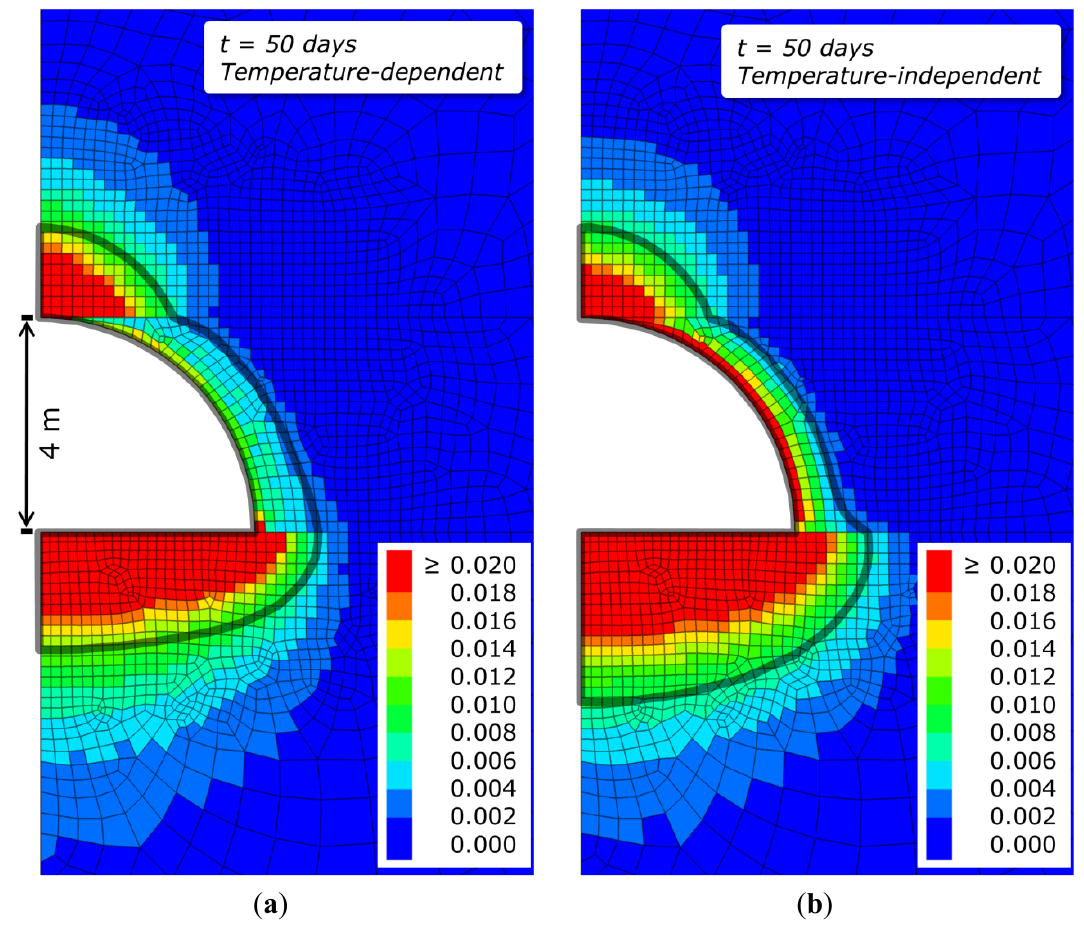
Figure 12. Distribution of positive volumetric strain increments with ( a ) temperature-dependent and ( b ) -independent properties in UCG reactor vicinity. The grey solid line represents the 200 °C